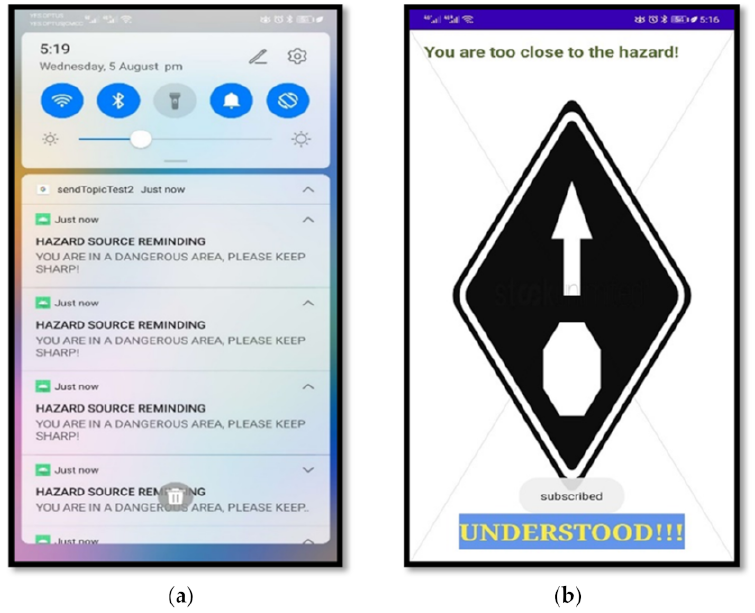
Figure 4. Application interfaces (( a ) when a hazard is notified and ( b ) when the user has confirmed the recognition of the